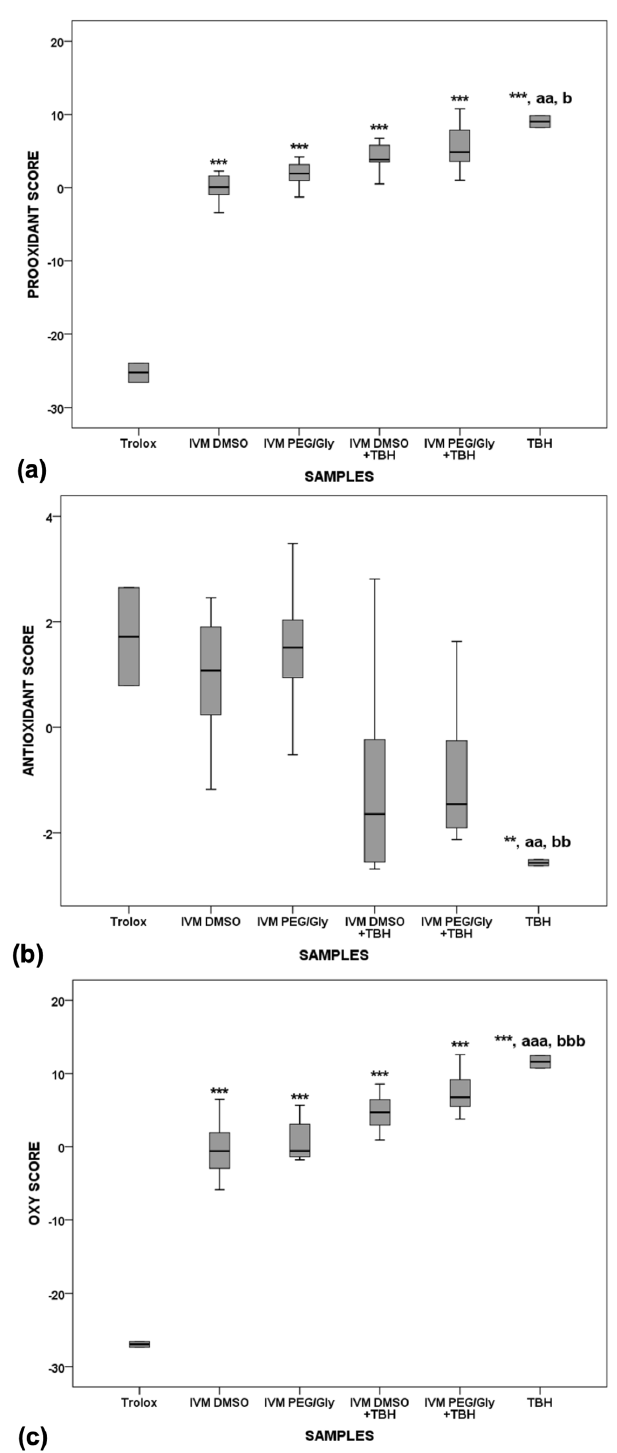
Figure 7. Pro-oxidant ( a ), antioxidant ( b ) and oxy-scores ( c ) after 24 h of incubation. ** p < 0.01 vs. Trolox; *** p < 0.001 vs. Trolox; aa p < 0.01 vs. IVM DMSO; aaa p < 0.001 vs. IVM DMSO; b p < 0.05 vs. IVM PEG/Gly; bb p < 0.01 vs. IVM PEG/Gly; bbb p < 0.001 vs. IVM PEG/Gly.